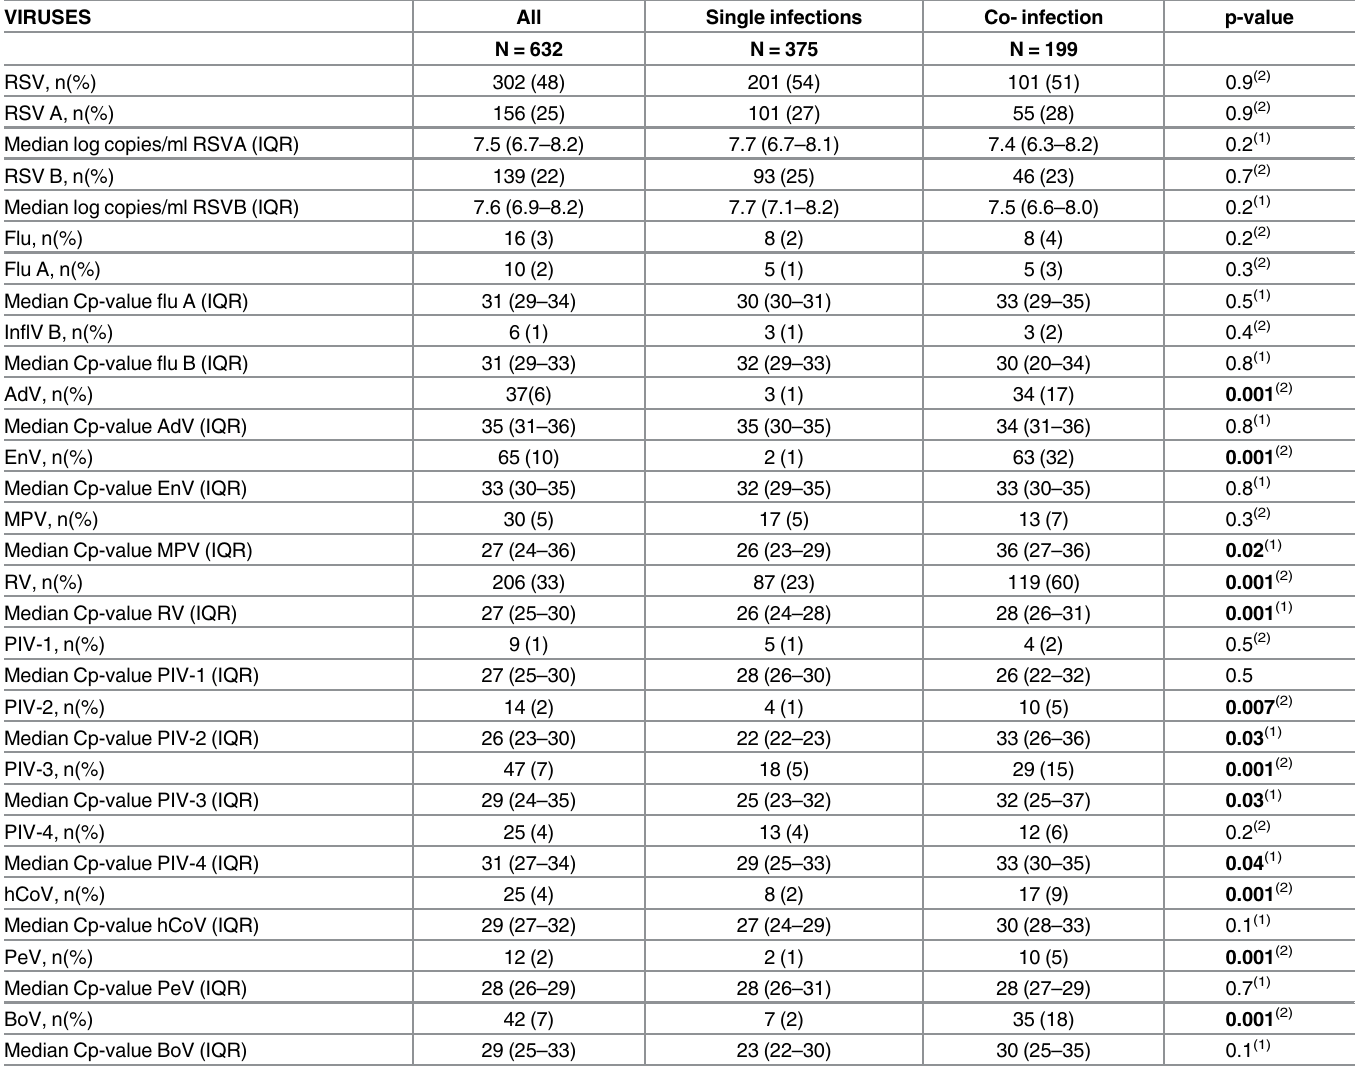
Table 2. Viral single and co-infections among all enrolled patients.